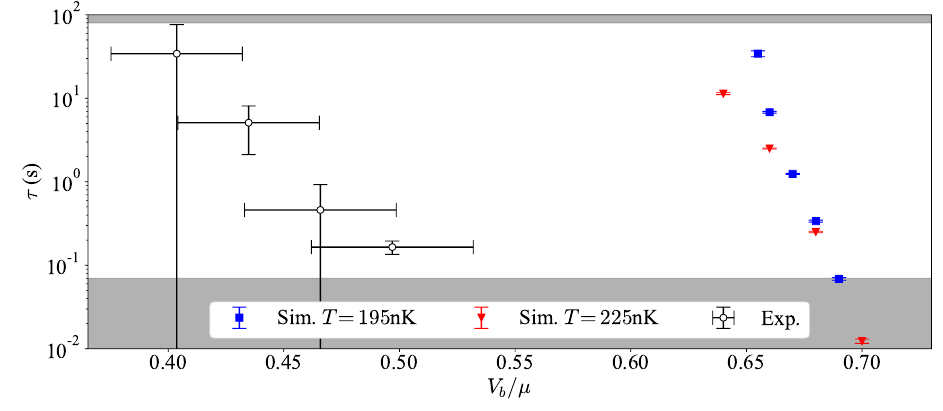
Figure 15: Decay timescale as a function of normalised barrier height, for the ex- perimental results for T = 195nK, and simulation results for T = 195nK (red dia- monds) and T = 225nK (blue squares). The temperature T = 225nK is the quoted experimental value plus its standard deviation, referring to the upper limit of a 68% confidence interval on the temperature of the experiment. There is a slight quan- titative difference between the two simulation trends, with the higher temperature associated with a gentler slope. However, this shift is not sufficient to explain the discrepancy with the experimental data. Error bars shown here represent a 95% confidence interval, with simulation data obtained from an ensemble average over 48 SPGPE